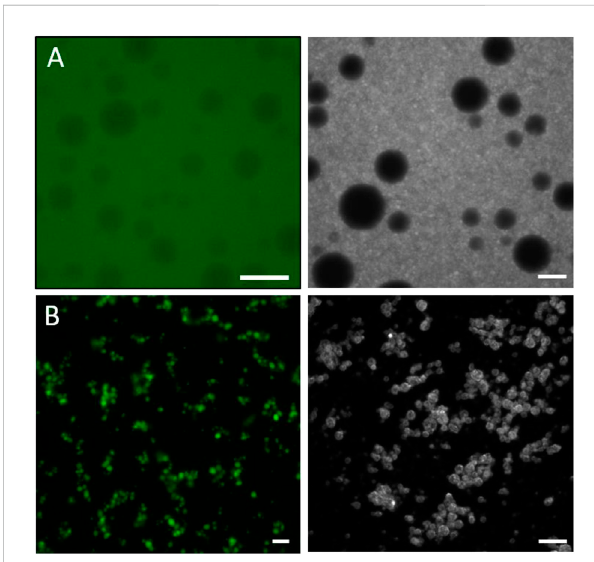
FIGURE 3 Panel (A) spatial localization of amino-silica based particles within solvent-free ATPS showing high fl uorescence (left epi fl uorescence microscopy) mainly out of Dex-rich droplets, i.e., in the outer PEG-rich continuous phase and white patches (right, dark fi eld microscopy). Panel (B) stabilization of ATPS upon solvent shifting using amino-silica based particles, showing smaller droplets than in the solvent-free ATPS. The inner core of droplets being fl uorescent (epi fl uorescence image, left) attests that particles are localized not only at the interface but also within Dex-rich droplets. These stable droplets can also be observed by dark fi eld microscopy (right). (Scale bars are for 20